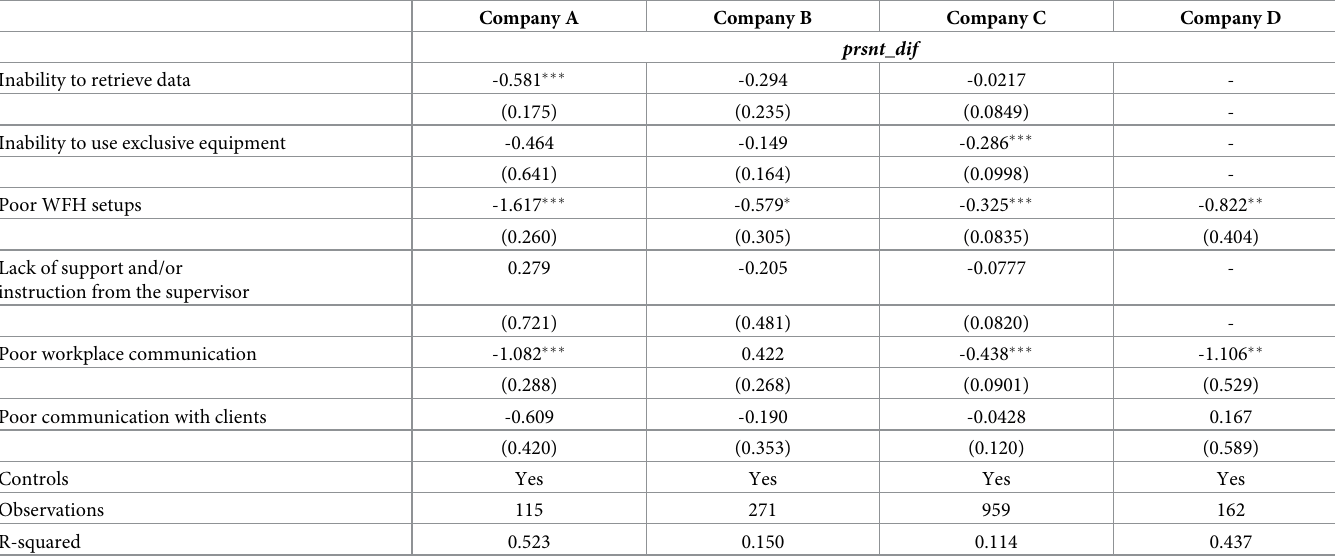
Table 8. Subsample analysis